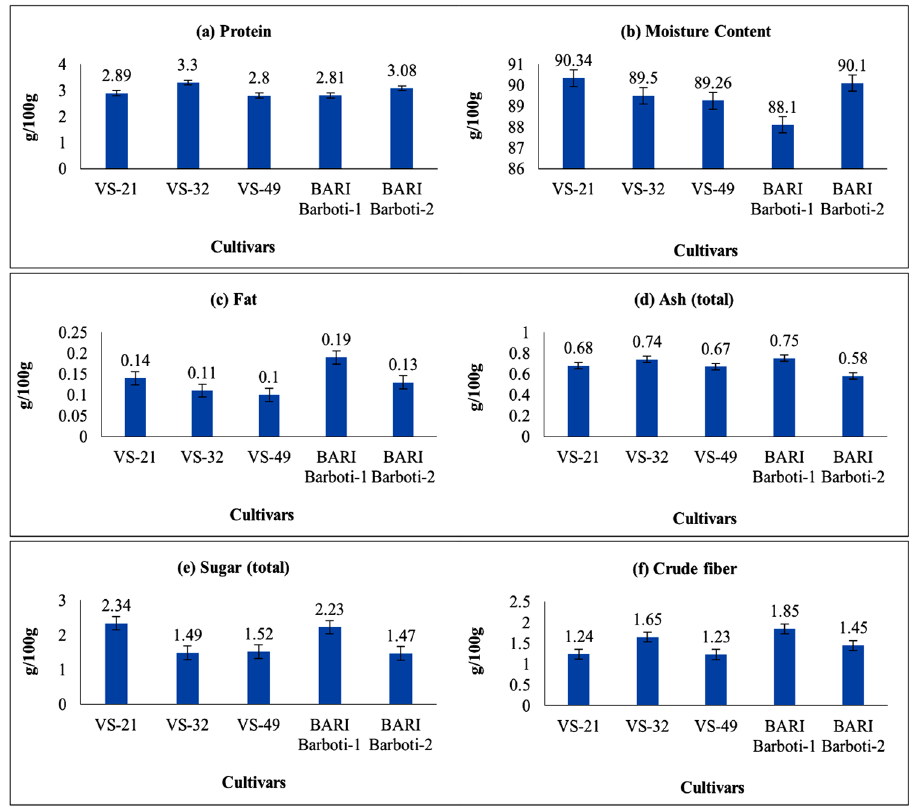
Figure 4. ( a ) protein, ( b ) moisture, ( c ) fat, ( d ) ash, ( e ) sugar and ( f ) crude fiber content of five yard- long bean cultivars commonly grown in Bangladesh [The parameters were estimated from 100 g dry